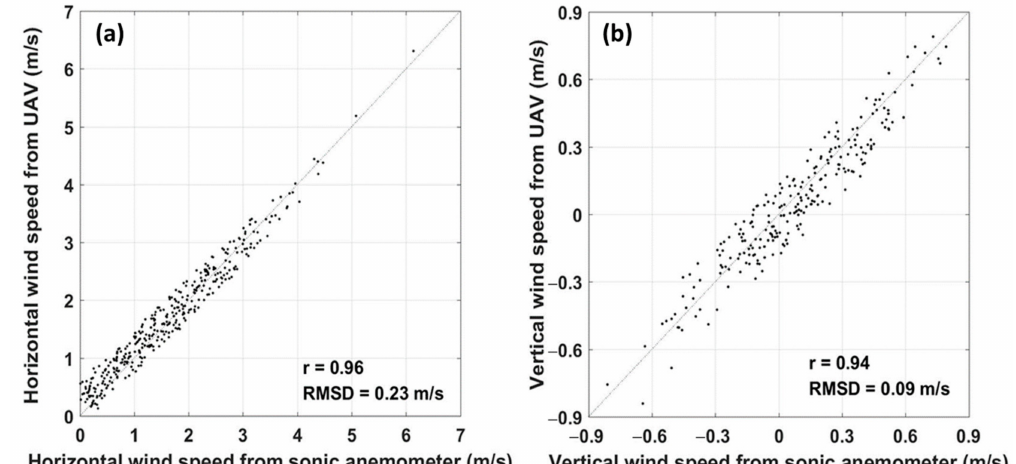
Figure 8. Comparison of the measured horizontal wind ( a ) and vertical wind ( b ) between the UAV and CSAT3 sonic anemometer during the ground-based comparison test on 31 May 2020. Wind vectors were calculated from the 30-s averaged instantaneous wind speed of every coordinate rotated 30-min wind sample segment. See Section 4.1 for details of the wind calculation for comparison purpose in this